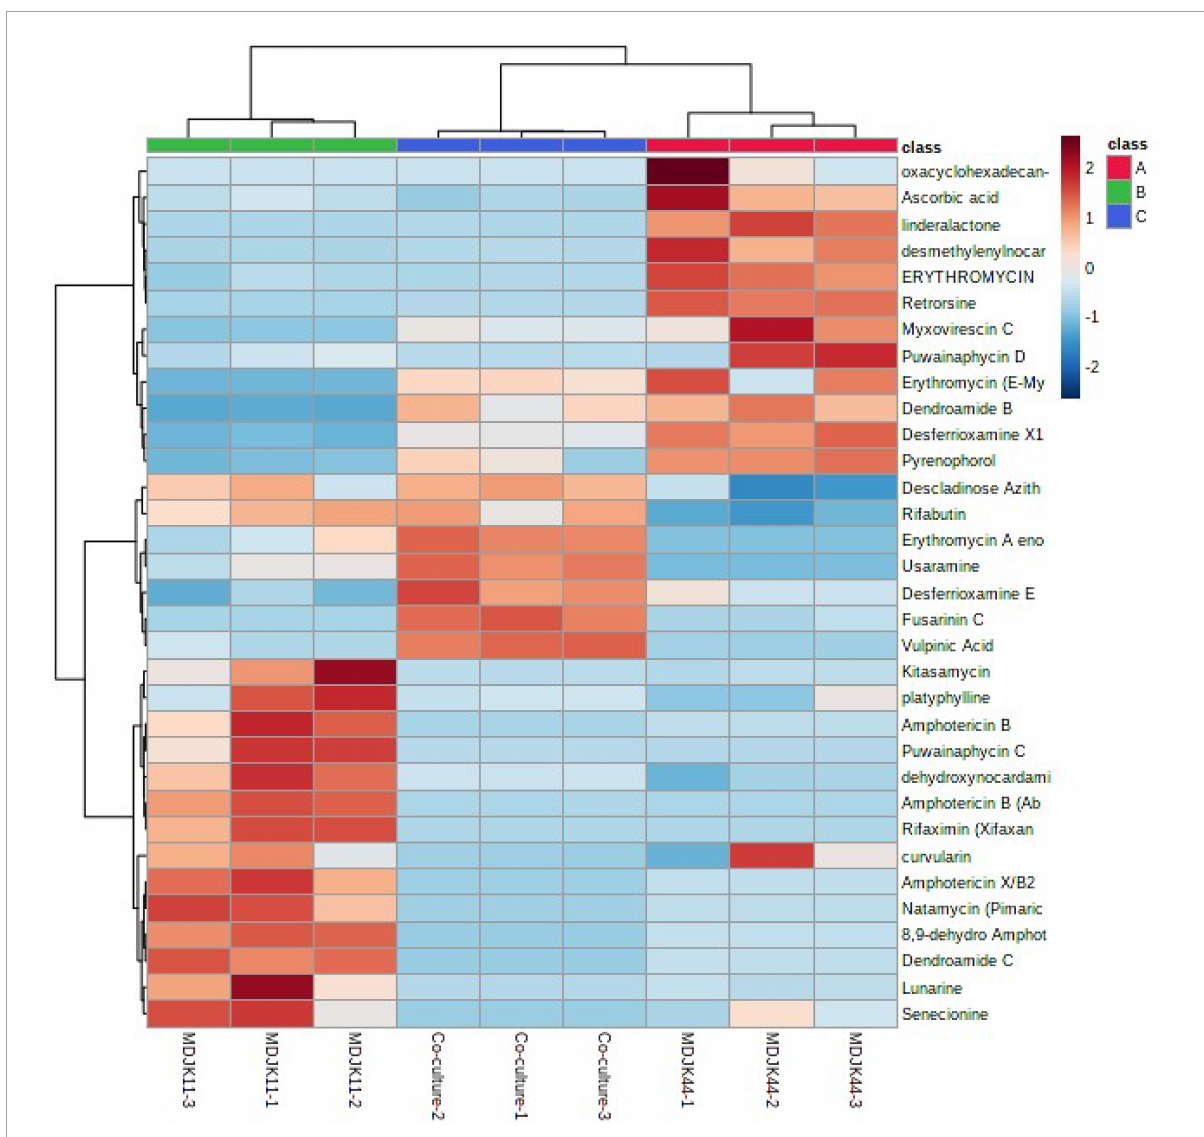
FIGURE11 Heat map of the identified antibiotics of Streptomyces MDJK11 and MDJK44 in monoculture and